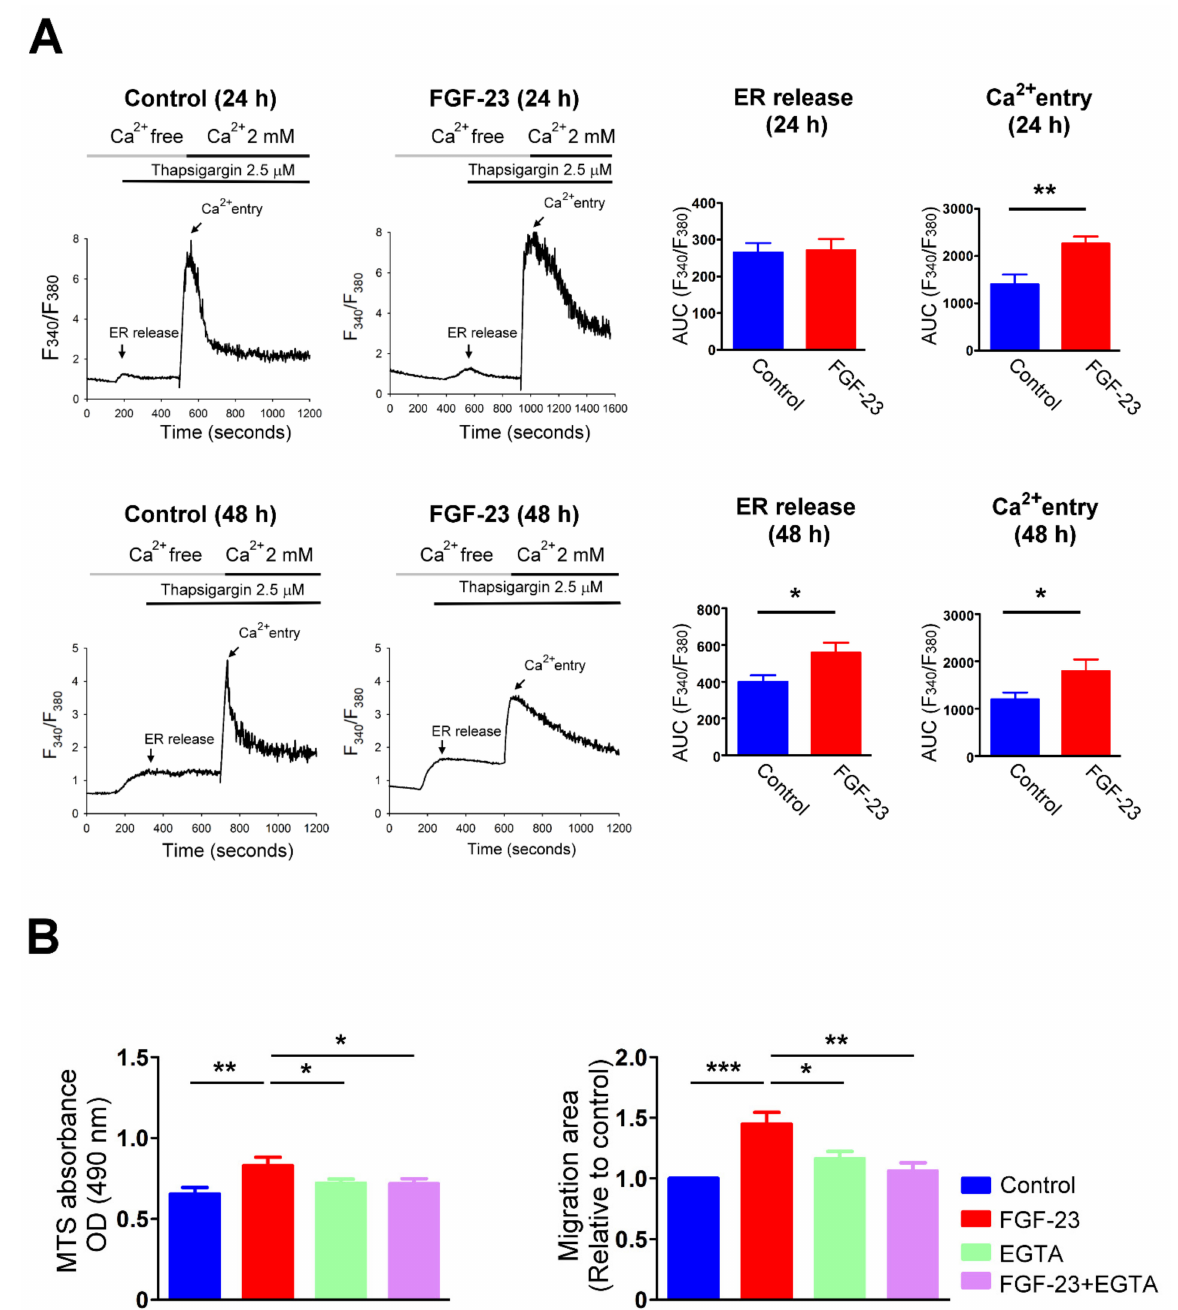
Figure 5. Intracellular calcium (Ca 2+ ) mediates the stimulatory effects of fibroblast growth factor (FGF)-23 on cardiac fibroblast proliferation and migration. ( A ) Representative fura-2 fluorescence tracings (left panel) indicates intracellular Ca 2+ transient after addition of 2.5 µ M thapsigargin (an endoplasmic reticulum (ER) Ca 2+ -ATPase inhibitor), and 2 mM Ca 2+ to an individual cardiac fibroblast without and with FGF-23 (25 ng/mL) treatment for 24 h and 48 h. Thus, the increases of Ca 2+ levels in cardiac fibroblasts following exposure to FGF-23 are not due to there being more cells present. The average Ca 2+ changes (right panel, n = 12 cells) were quantified as the area under the curve (AUC) values of fluorescence intensities (F340/F380) corresponding to ER Ca 2+ release and extracellular Ca 2+ entry. ( B ) Average data of a MTS assay to study cell proliferation (left panel) and a wound-healing assay to evaluate cell migration (right panel) in control and FGF-23 (25 ng/mL)- treated cardiac fibroblasts without and with ethylene glycol tetra-acetic acid (EGTA, a free Ca 2+ chelator, 1 mM) treatment ( n = 5). * p < 0.05, ** p < 0.01, *** p <